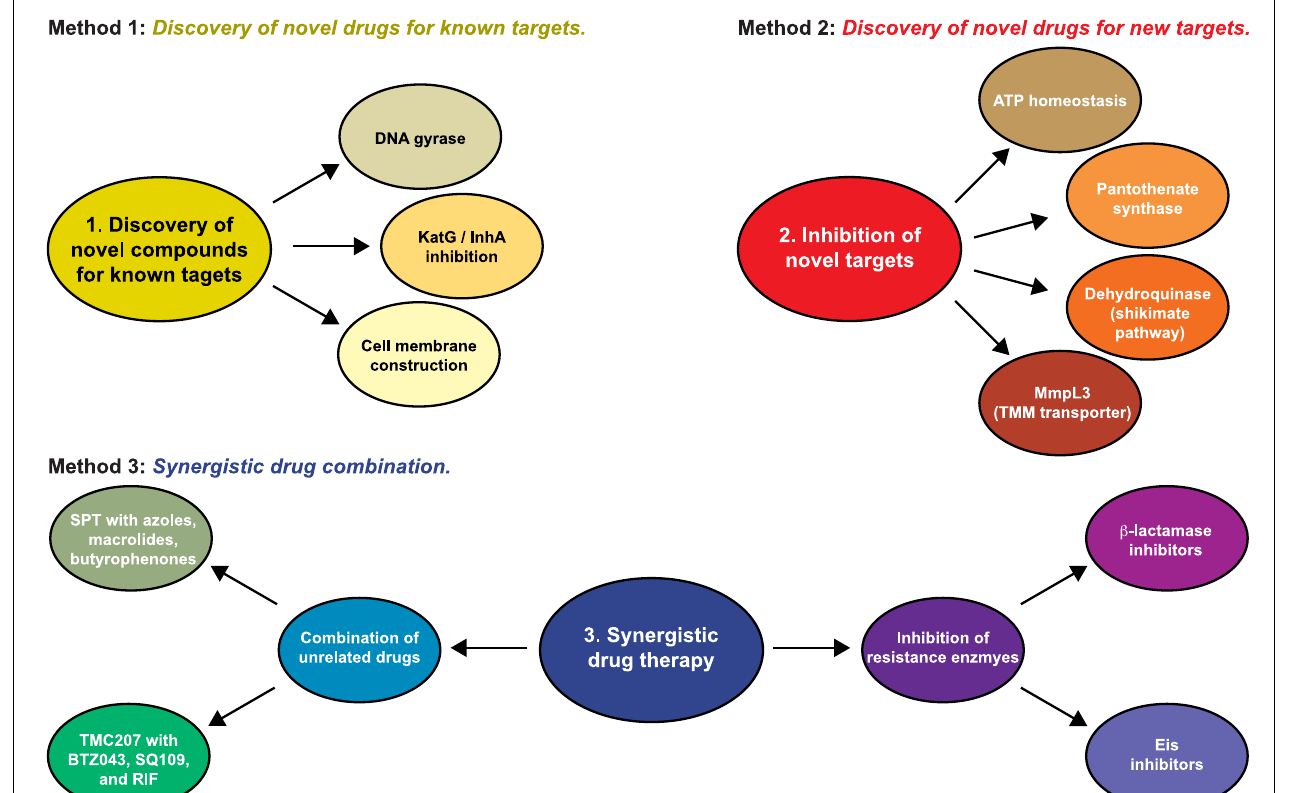
FIGURE 1 | (A) Structures of the anti-TB drugs discussed in this mini-review. (B) Schematic representation of the three methodologies explored to overcome resistance in Mtb .